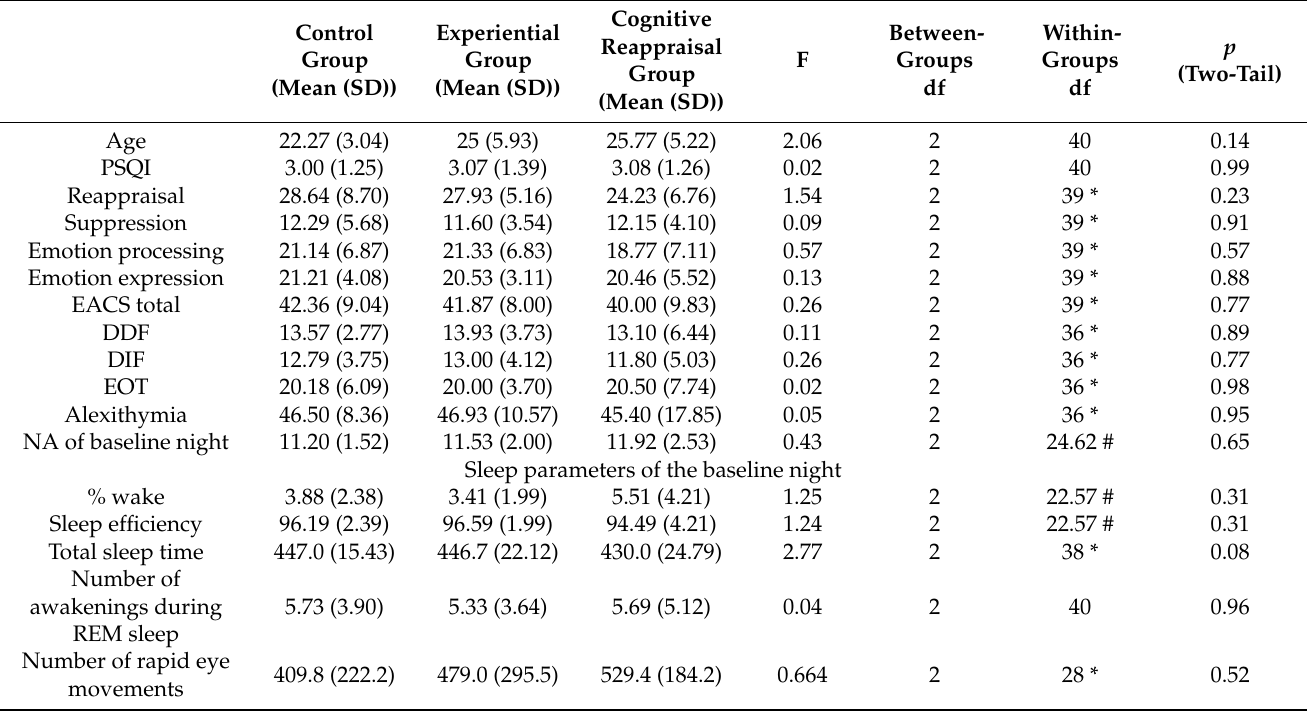
Table 1. Mean (standard deviation) for age, PSQI and the questionnaire scores under control, experiential emotion regulation, and cognitive reappraisal condition. Mean (standard deviation) for NA and sleep physiology under control, experiential emotion regulation, and cognitive reappraisal condition on the baseline night. Moreover, the obtained F, degree of freedom, and p values from one-way ANOVA for each dependent variable were reported a,b,c